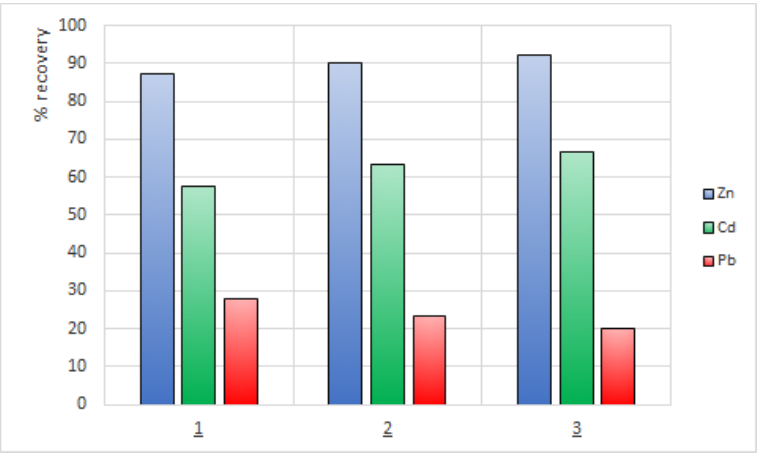
Figure 8. Recovery factor (RF) of zinc, cadmium and lead during transport across PIMs with 1-hex- yltriazole ( 1 ), 1-octyltriazole ( 2 ), and 1-decyltriazole ( 3 ). hexyltriazole ( 1 ), 1-octyltriazole ( 2 ), and 1-decyltriazole ( 3